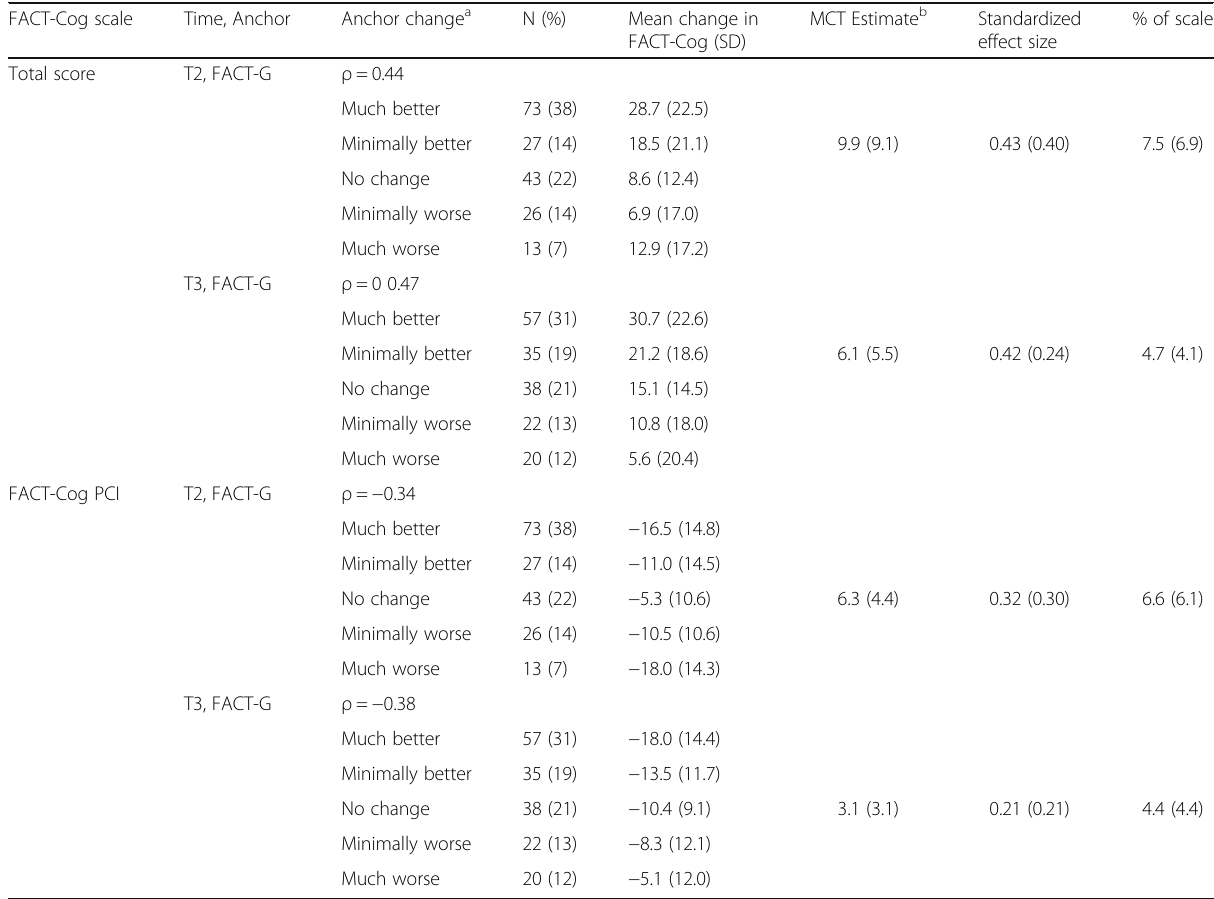
Table 5 Anchor-based CID estimates for improvement for the FACT-Cog total score (33 item) and FACT-Cog-PCI based on changes from baseline at post-intervention (T2) and six month follow-up (T3) and secondary anchor FACT-G . Correlations, ρ , are for the change in the FACT-Cog total score or PCI subscale and the categorized anchor changes FACT-Cog scale